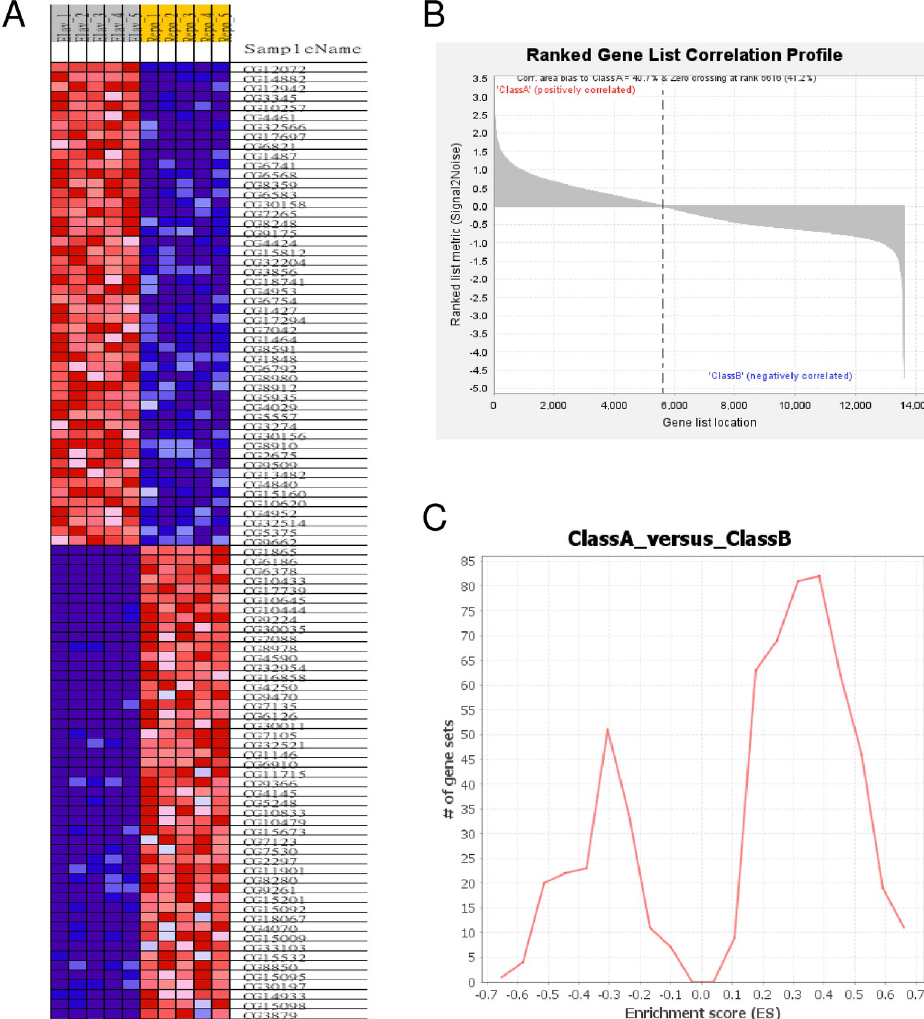
Fig 1. Global characteristics of the ELAV vs REPO profiling analyzed with the Reactome gmt. A) Heat Map of the top 50 features for each phenotype. B) Ranked Gene List Correlation Profile. C) Global enrichment scores across gene sets (ES